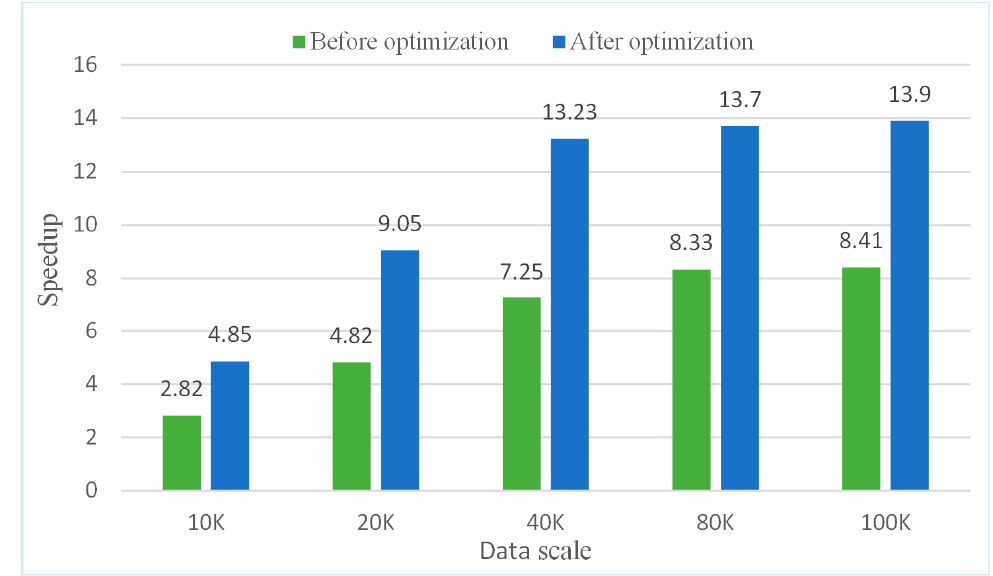
Figure 19. Comparison of achieved Speedup before and after the optimization.